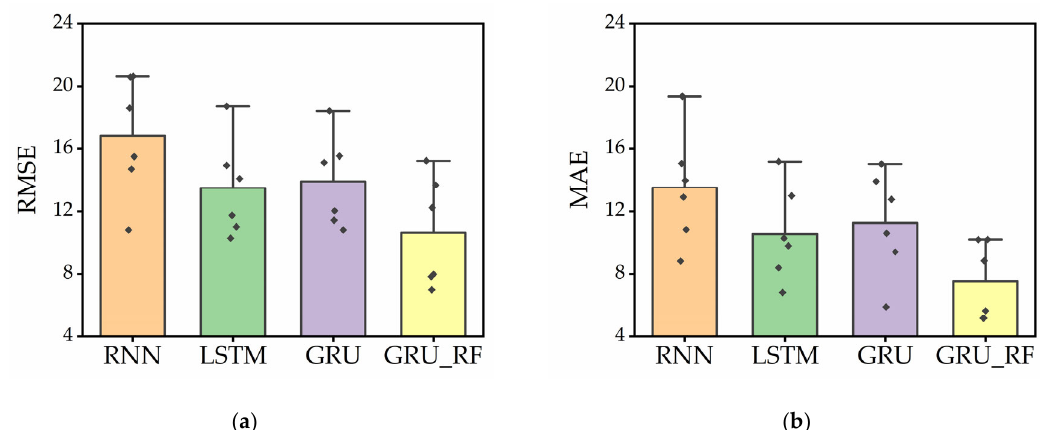
Figure 18. Comparison of prediction performance of RNN, LSTM, GRU, and GRU_RF on test wells with two evaluation indices: ( a ) RMSE; ( b ) MAE.